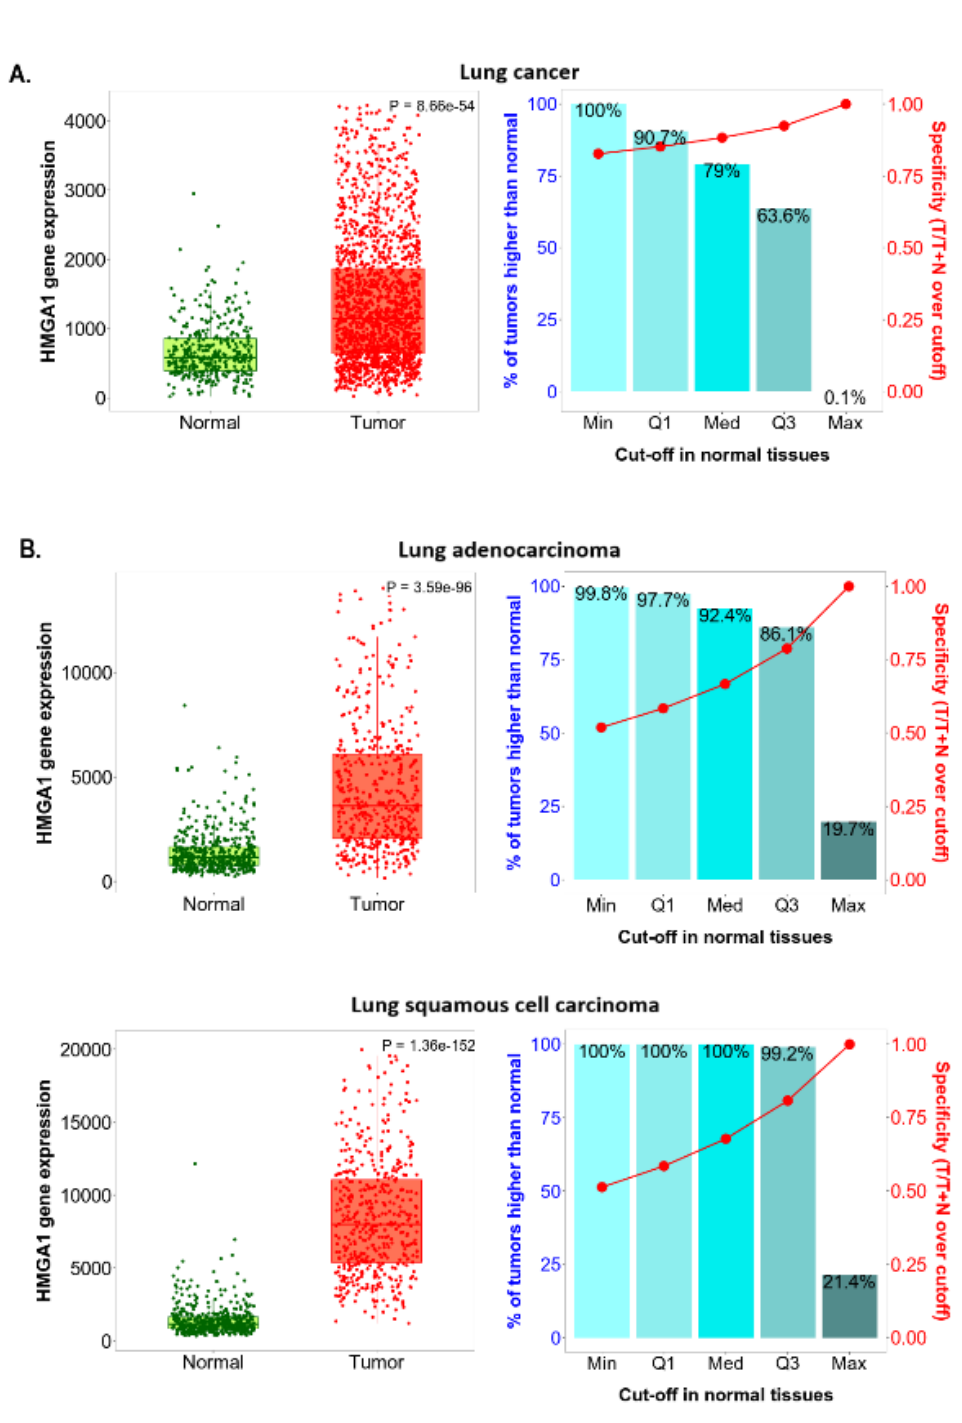
Figure 5. HMGA1 expression level in non-paired tumor and normal tissue by TNMplot. ( A ) Gene chip data for lung cancer. ( B ) RNA-Seq data for adenocarcinoma and squamous cell carcinoma. 2.3. HMGA1 Is Widely Overexpressed in Different Histological Types of Lung Tumour The histological characteristics of the lung cancer tissue substantially influence the behavior of neoplastic cells, determine cancer prognosis, and direct treatment regimens applied. Thus, we explored the HMGA1 mRNA expression data from Oncomine related to small cell lung cancer, the main three subtypes of non-small cell lung cancer, and lung carcinoids. Consistent HMAG1 overexpression was found across different non-small cell lung cancer subtypes: adenocarcinoma (Figure 6A), squamous cell carcinoma (Figure 6B), and large cell carcinoma (Figure 6C). HMGA1 upregulation was observed in small cell